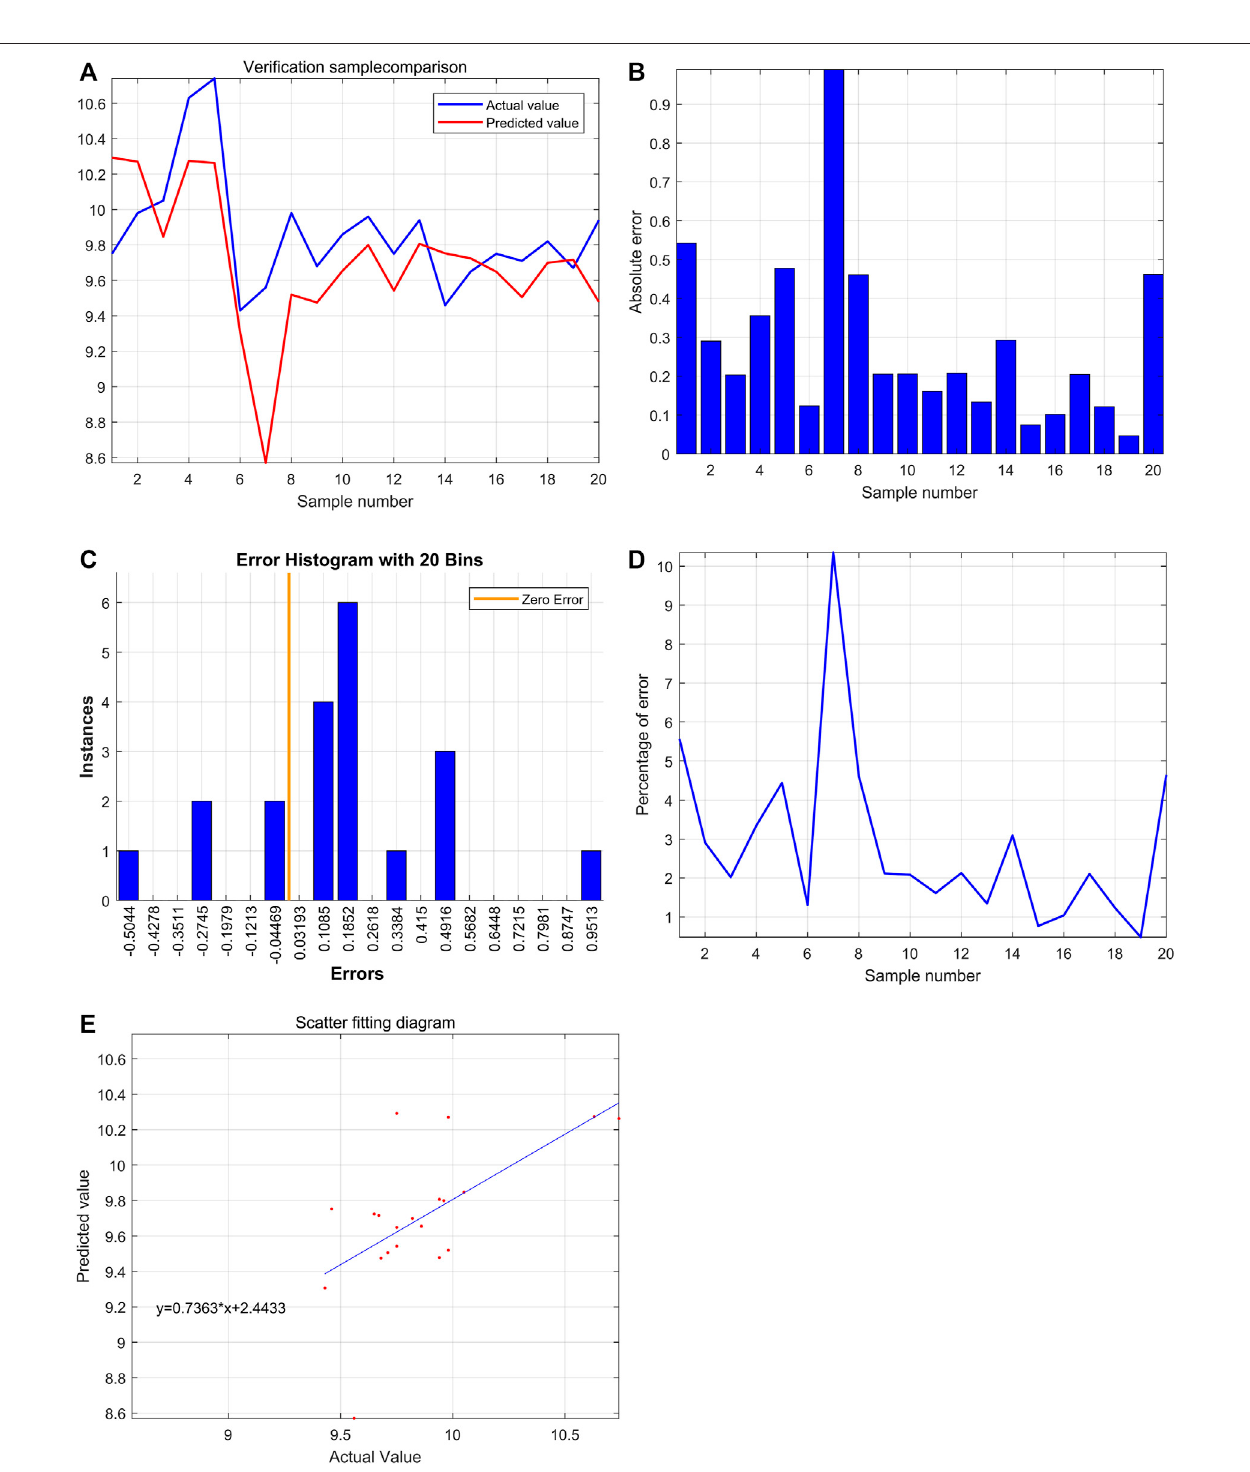
FIGURE 9 | Signi fi cant effect of HBG1 and HBD on the blood coagulation function based on the support vector machine. (A) Through the comparison between actual value and predicted value, the variation tendency was similar. (B) Most absolute errors were less than 0.5. (C) Error histogram with 20 bins. (D) Curve of the percentage error was also drawn, and the most percentage errors were all less than 5%. (E) In the scatter fi tting diagram, the relationship between the predicted value and the actual value is given by y = 0.7363*X+2.4433.